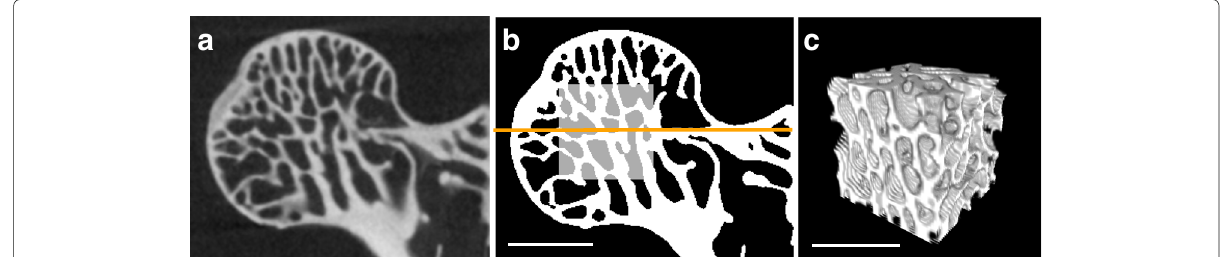
Fig. 2 Workflow for the selection of the cubic volume of interest (VOI) in the femoral head. Selection of the VOI is shown with a specimen of Tamias rufus (SNMNH, 564127). a Micro-CT coronal slice, 16-bit grayscale image. b Selection of the cubic VOI in the center of the femoral head. The horizontal orange line indicates the central slice which divides the femoral head and the VOI into a proximal and a distal half. The VOI was expanded in three dimensions as much as possible without including cortical bone. c 3D view of the final selection after cropping the image stack. Analysis of trabecular architecture was executed on this substack. Note that these pictures serve as a demonstration for the VOI selection but do not conform with the proper analysis done on this specimen. Scale bars: 1